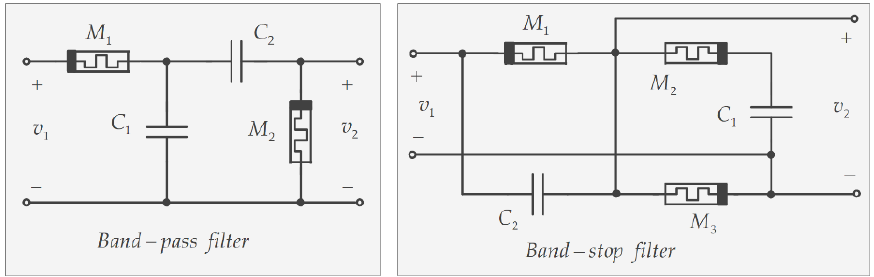
Figure 16. Band-pass and band-stop memristor-based filters.